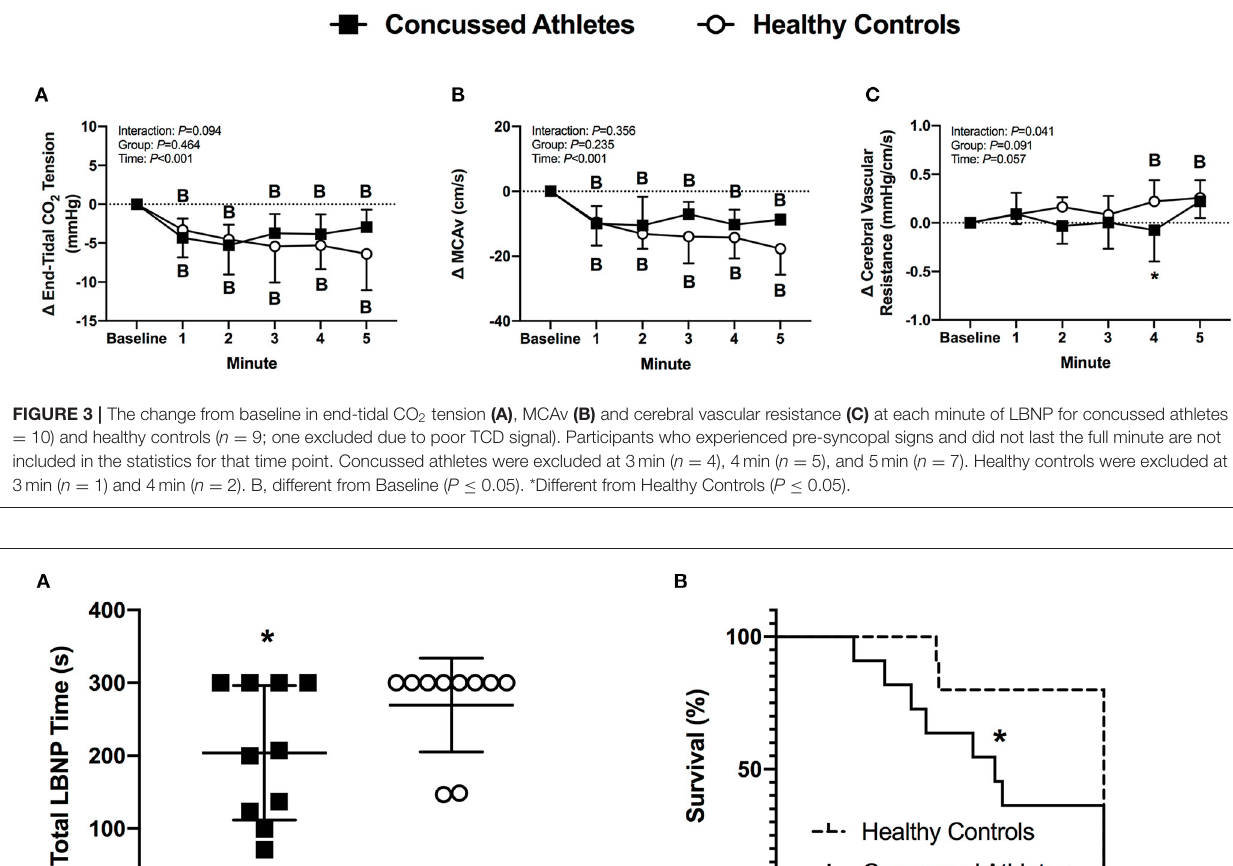
exacerbation of symptoms from pre-LBNP (2 ± 2) to post-LBNP (4 ± 2; P = 0.006) ( Figure 5